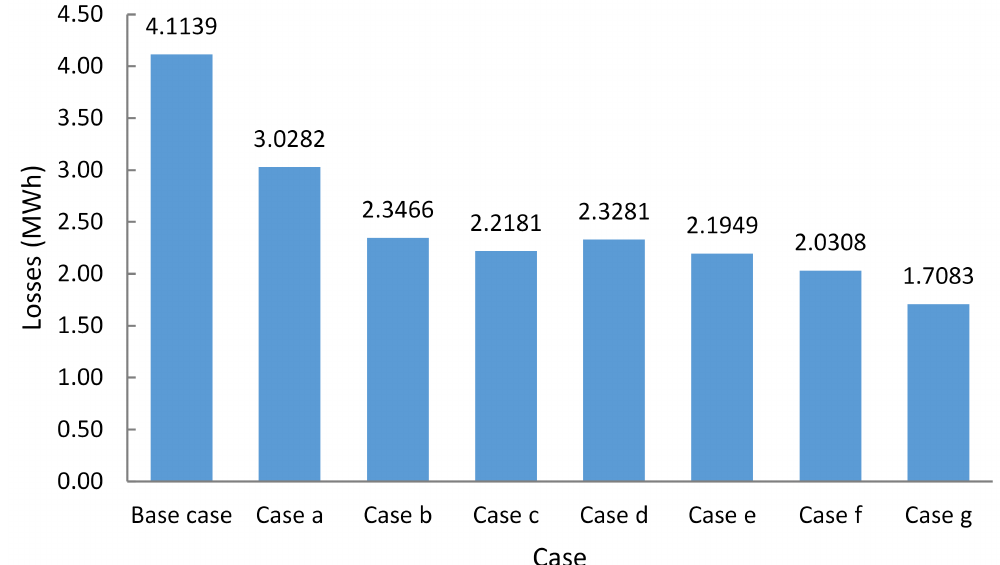
Figure 4. Active losses in the tested cases.